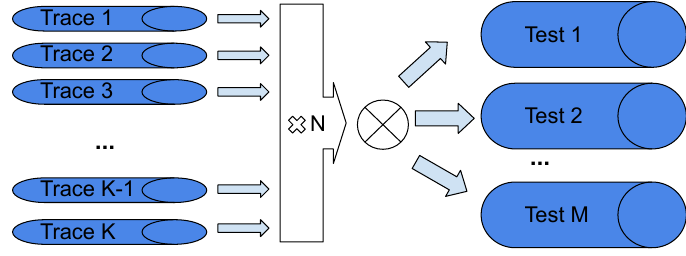
Figure 6. Trace mixing